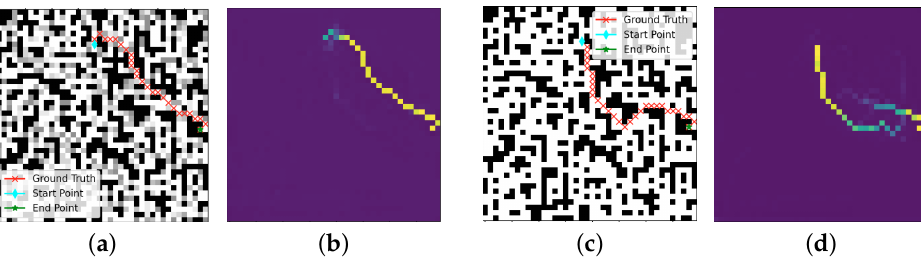
Figure 4. Example of the ground-truth, environment, and probability maps. ( a ) Ground truth and environment of the lowest-cost path of the sample. ( b ) Probability map of the shortest path of the sample. ( c ) Ground truth and environment of the shortest path of the sample. ( d ) Probability map of the shortest path of the sample.